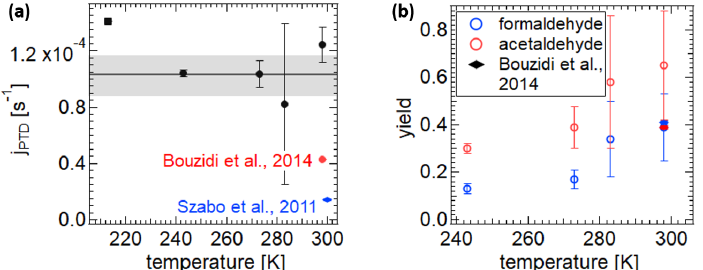
Figure 6. (a) Photolysis frequencies of the photolysis of 2,3-pentanedione for the experiments at different temperatures and the photolysis frequencies measured by Szabo et al. (2011) and Bouzidi et al. (2014). (b) The product yields for the corresponding experiments. The wall loss at 213K was too high to perform a model run for the product yield. The photolysis frequency for this temperature shown in the figure is the upper limit with the assumption of a minimal wall loss, equivalent to the value after